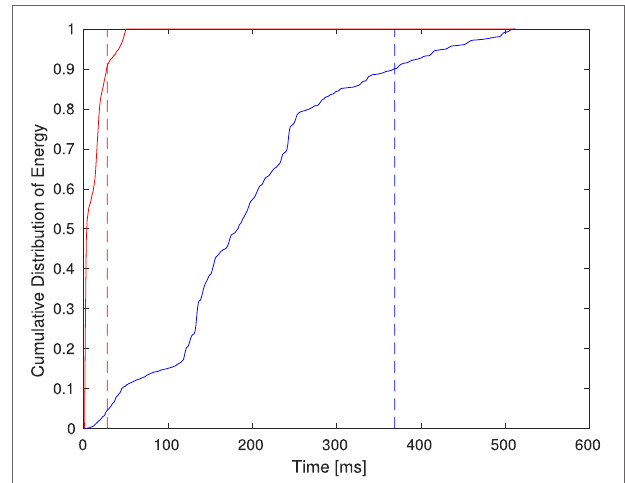
FIGURE 2 | Comparison of the cumulative distribution of energy over time for footsteps (left, solid red curve) and doors being closed (right, solid blue curve). The dashed vertical red line at 28ms shows where the footstep energy reaches its 90th percentile of its total energy and the dashed vertical blue line at 370ms shows where the door closing event energy reaches its 90th